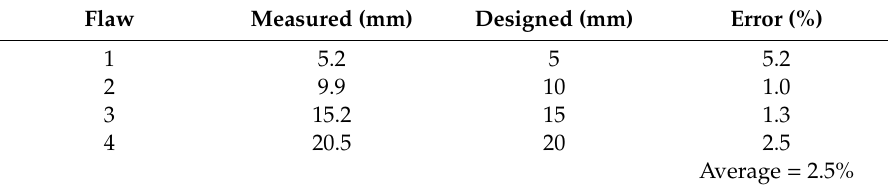
Figure 4. Grayscale profile in a horizontal line for the 5 mm defects. Table 1. Comparison of the Flaw Diameters with Measured and Designed.